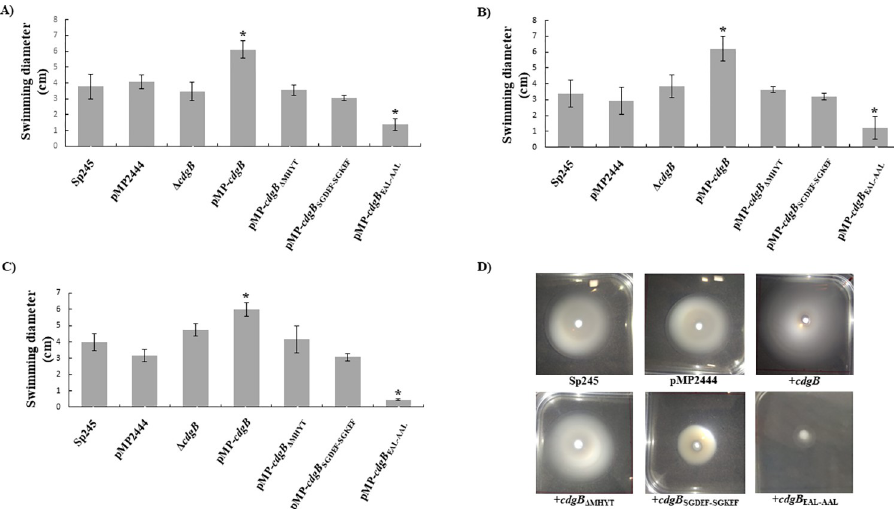
Fig 7. CdgB alters swimming motility in A . baldaniorum Sp245. Graph representing the mean of motility halos, in centimeters (cm), of the indicated strains on K-media plates with agar 0.25%, supplemented with (A) malate, (B) succinate, or (C) proline (10mM) at 30˚C for 48 h. Error bars indicate standard deviations of 6 replicates per strain. (D) Representative images of motility halos from three independent experiments with two biological determinations. Significant differences relative to WT ( P < 0.005) according to Student´s t-test are indicated by “ � ”.